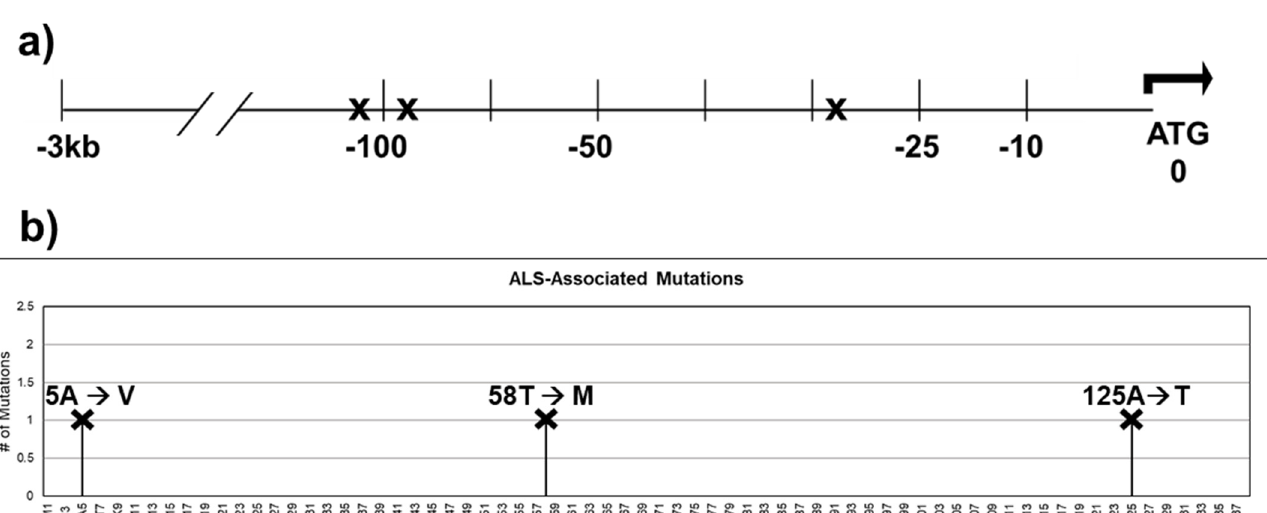
Figure 4. SNPs identified in cancer patients within the 3 kb upstream regulatory region and the coding sequence of CRABP1. ( a ) Gene diagram of the 3 kb upstream region of CRABP1 with SNPs denoted by “ ● ”. ( b ) Lollipop plot indicating the location of amino acid mutations as a consequence of cancer-associated SNPs.